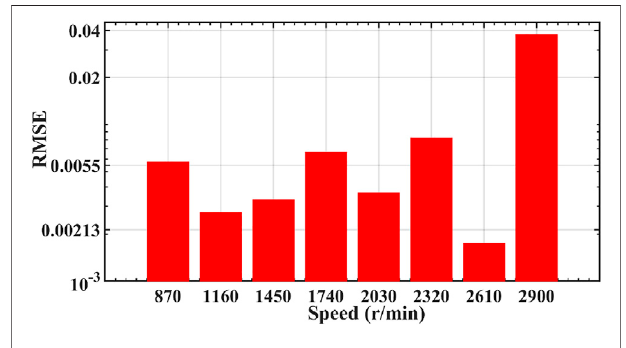
FIGURE 8 | Generalization ability of the prediction model.